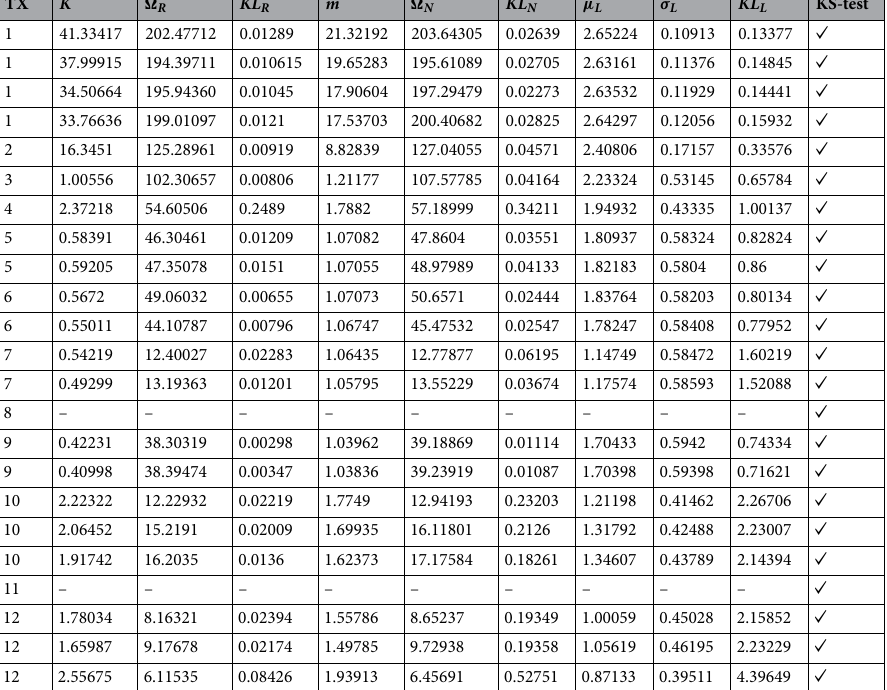
Table 6. Aalto university entrance hall links parameters of the Rice, Nakagami-m and Lognormal